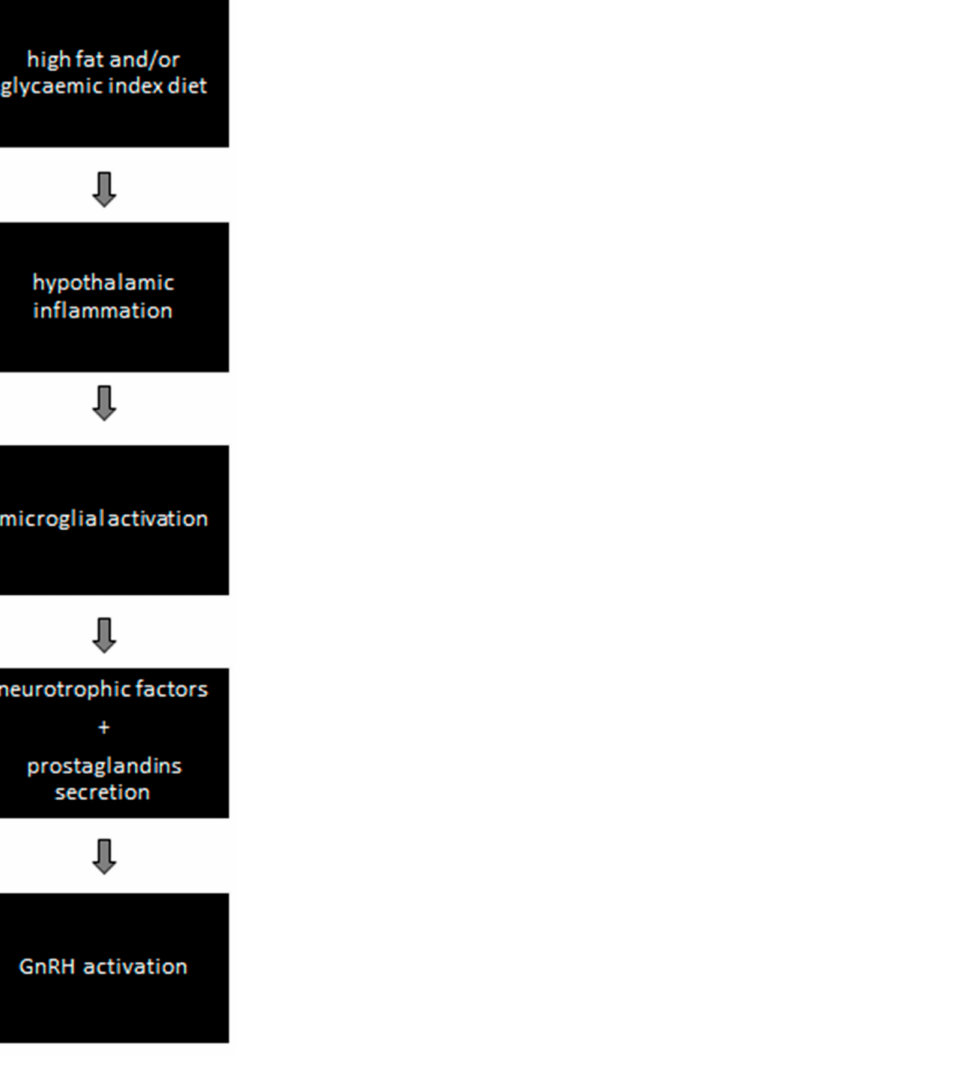
Figure 1. Diet-induced hypothalamic microglial activation and GnRH